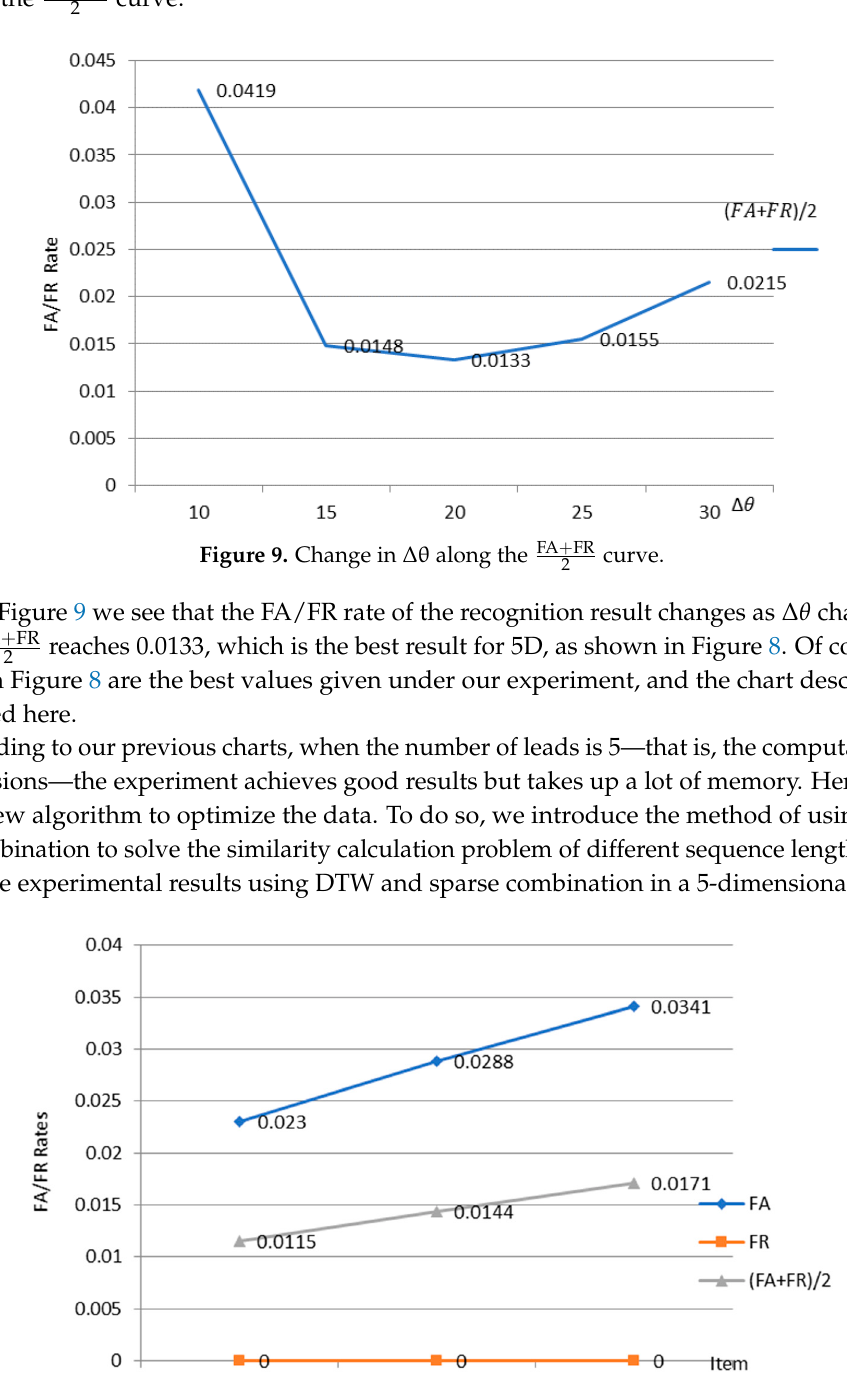
Figure 10. Comparison of DTW and Sparse Combination Parameters in 5D space.